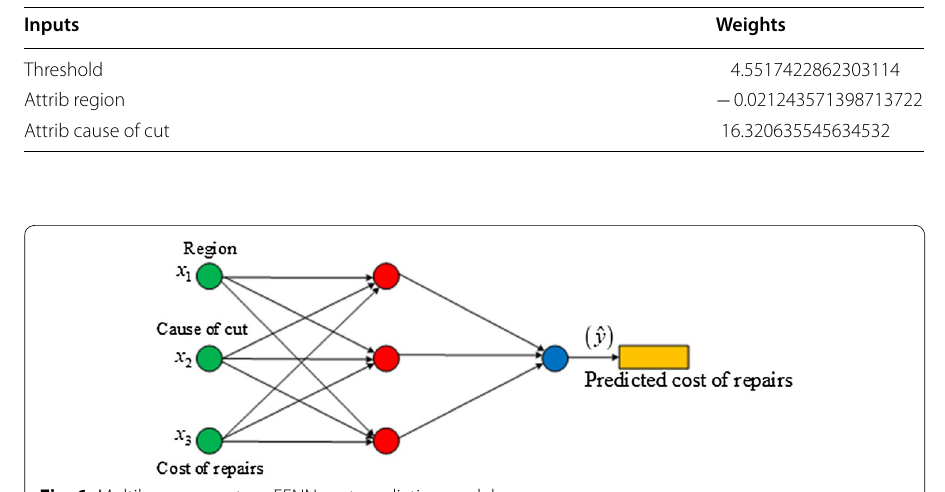
Fig. 6 Multilayer perceptron FFNN cost predictive